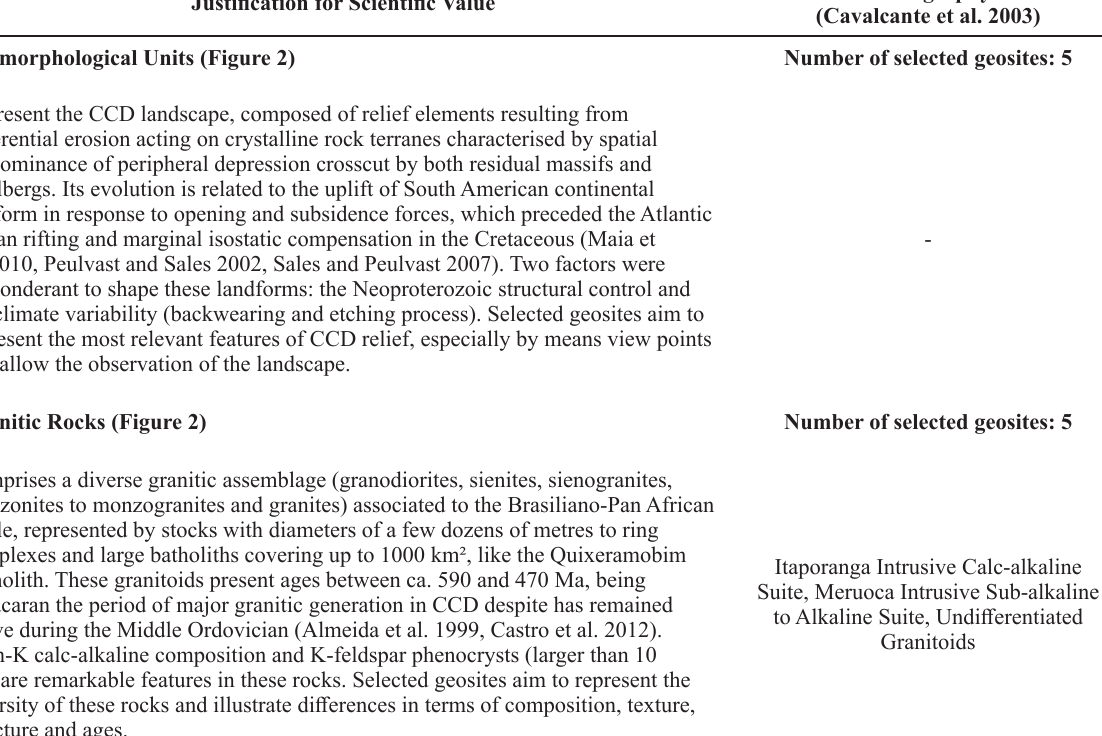
Litho-stratigraphy units (Cavalcante et al. 2003)